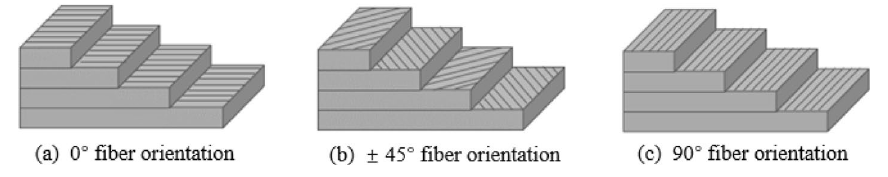
Figure 1. Three kinds of laying